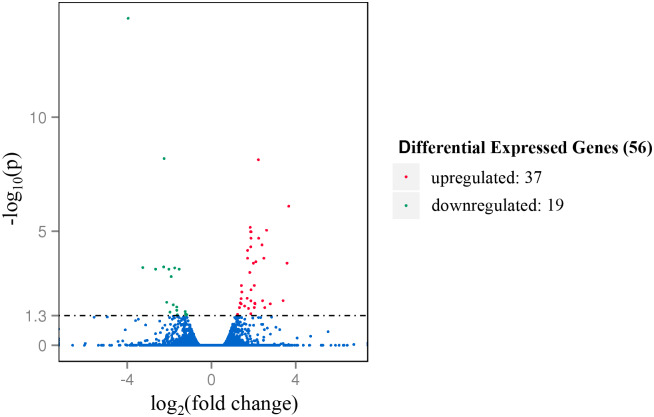
Volcano Plot of DEGs in LL muscle comparing steers versus bulls.The x-axis shows the values of log2 (fold change), while the average expression values of log10 (p) are displayed by the y-axis. The red and green dots represent the significantly differentially expressed transcripts (p < 0.05) comparing the LL muscle of steers versus bulls, with red for upregulated genes and green for downregulated genes. The blue dots indicate the transcripts with expression levels which are not statistically significant (p > 0.05) comparing steers and bulls.